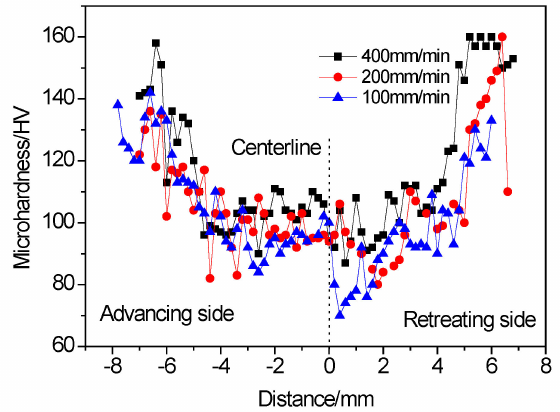
Figure 6. Micro − hardness distribution on crossing section of welds at various welding